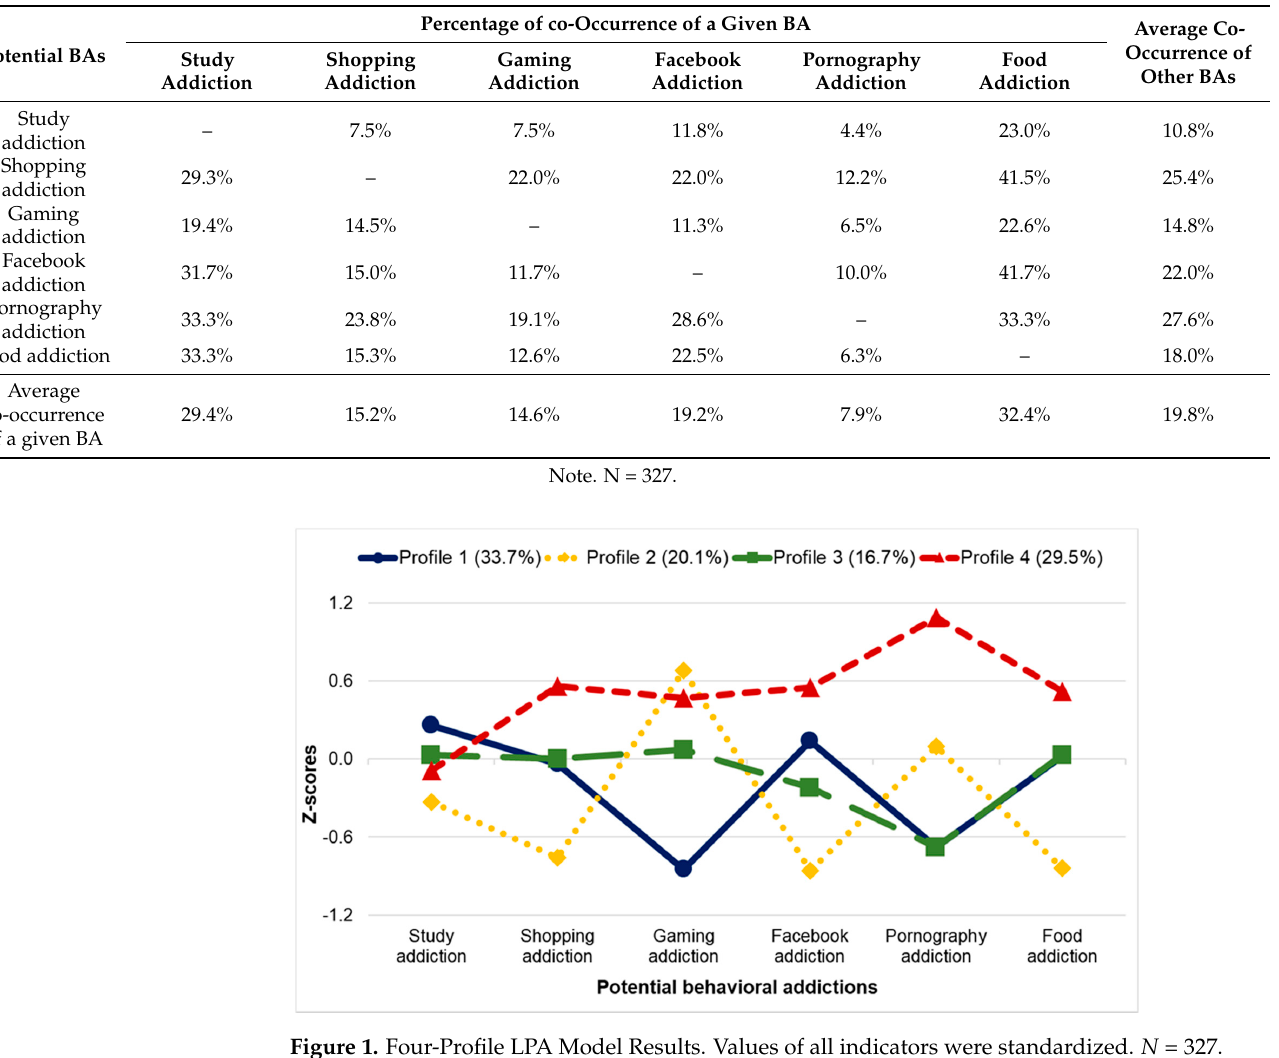
Figure 1. Four-Profile LPA Model Results. Values of all indicators were standardized. N = 327.